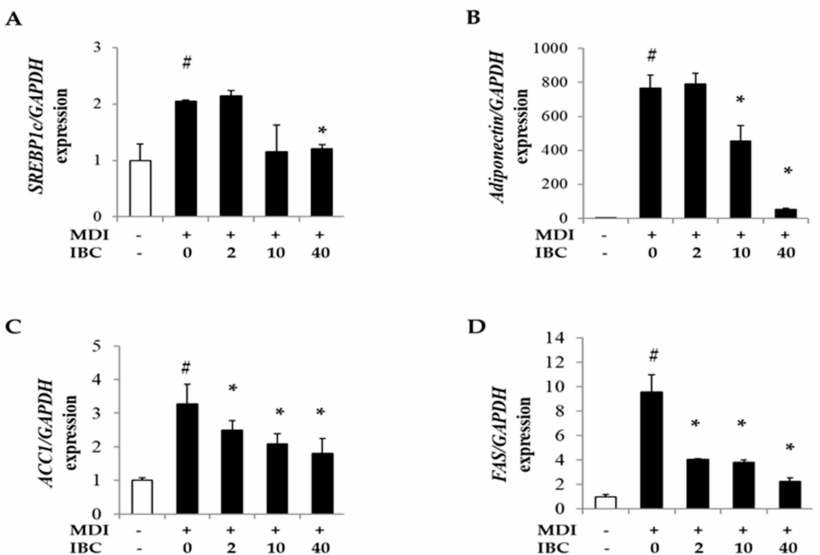
Figure 4. Effect of IBC on levels of lipid metabolism related genes. 3T3-L1 adipocytes were differentiated with IBC at indicated concentrations. On D5, cells were harvested and cell lysates were used for RNA extraction followed by cDNA synthesis and qPCR to analyze gene expression levels of SREBP1c ( A ); adiponectin ( B ); ACC1 ( C ); and FAS ( D ). Data are presented as means ± SD of triplicate experiments. # p < 0.01 vs. control; * p < 0.01 vs. MDI